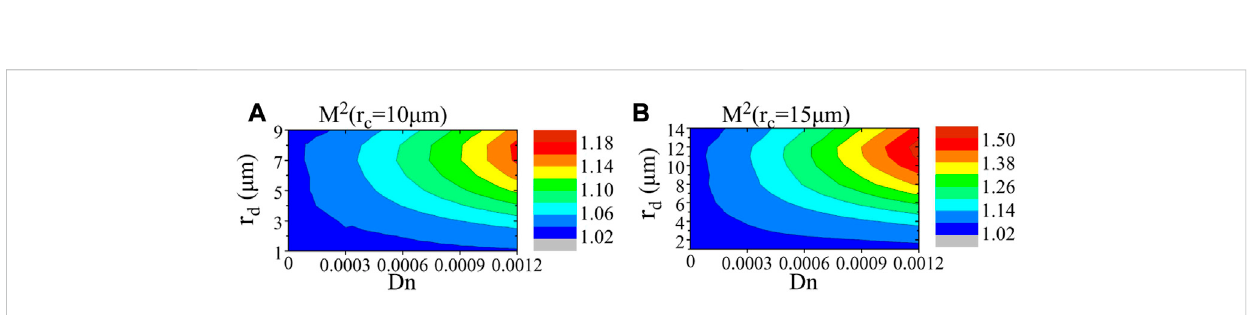
FIGURE 6 Theoretical calculated beam quality M 2 under different dip radii and depths for fi bers with a core radius of (A) 10 μ m; (B) 15 μ